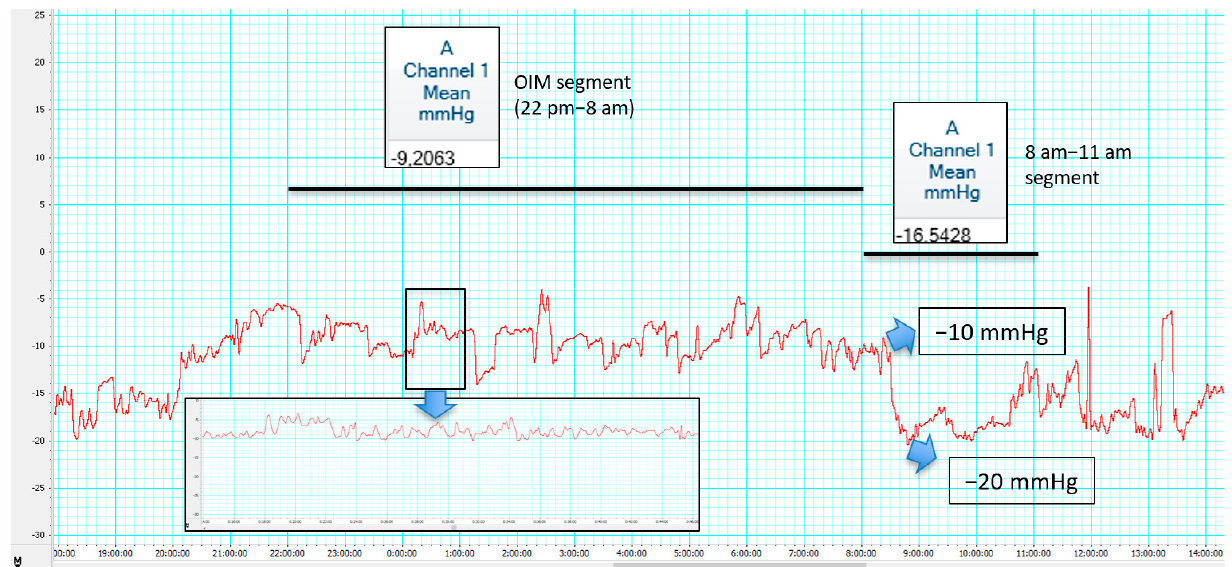
Figure 2. A 42-year-old female, pseudotumor cerebri treated by lumboperitoneal shunting (adjustable non-syphon control device). Chronic non-postural headache. Fundoscopy not fully reliable due to previous sequelae of papilledema. ICP monitoring revealed negative pressures during overnight ICP monitoring (OIM) segment (2200 to 0800) with a mean pressure of − 9 mmHg, presenting a fall from − 10 to − 20 mmHg at the time of the tilting test after awakening, followed by a discrete rise with a mean of − 16 mmHg in the interval from 0800 to 1100. Slow wave segments were also found (e.g., B waves up to 5 mmHg in amplitude from 2400 to 0100). Intracranial hypotension was diagnosed and valve upgrading obtained symp- tomatic improvement. Codman Microsensor ® ICP Transducer, Codman ® ICP EXPRESS Monitor ® (Integra LifeSciences Corporation, Princeton, NJ, USA)/ML856 PowerLab 26T, ML132 Bio Amp ADInstruments, INC/Personal Computer Chart